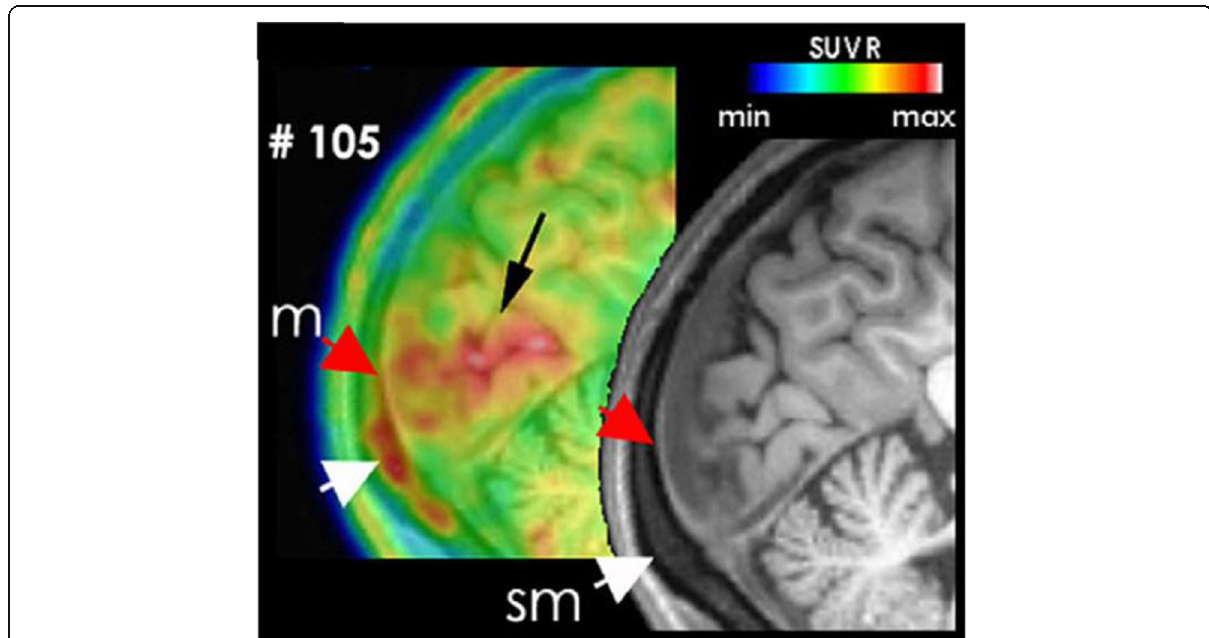
Fig. 1 [(11) C]PBR28 PET/MRI showing inflammatory activity in the occipital cortex (black arrow), overlying meninges (red arrows), and bone marrow (white arrows) in a patient suffering from migraine with visual aura attacks (from [13] with